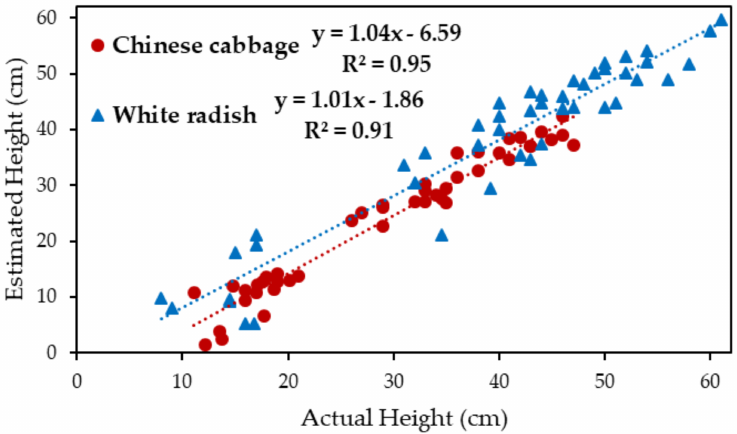
Figure 10. Relationships between the heights of Chinese cabbage and white radish determined by the structure from motion (SfM) method and by use of a 1 m